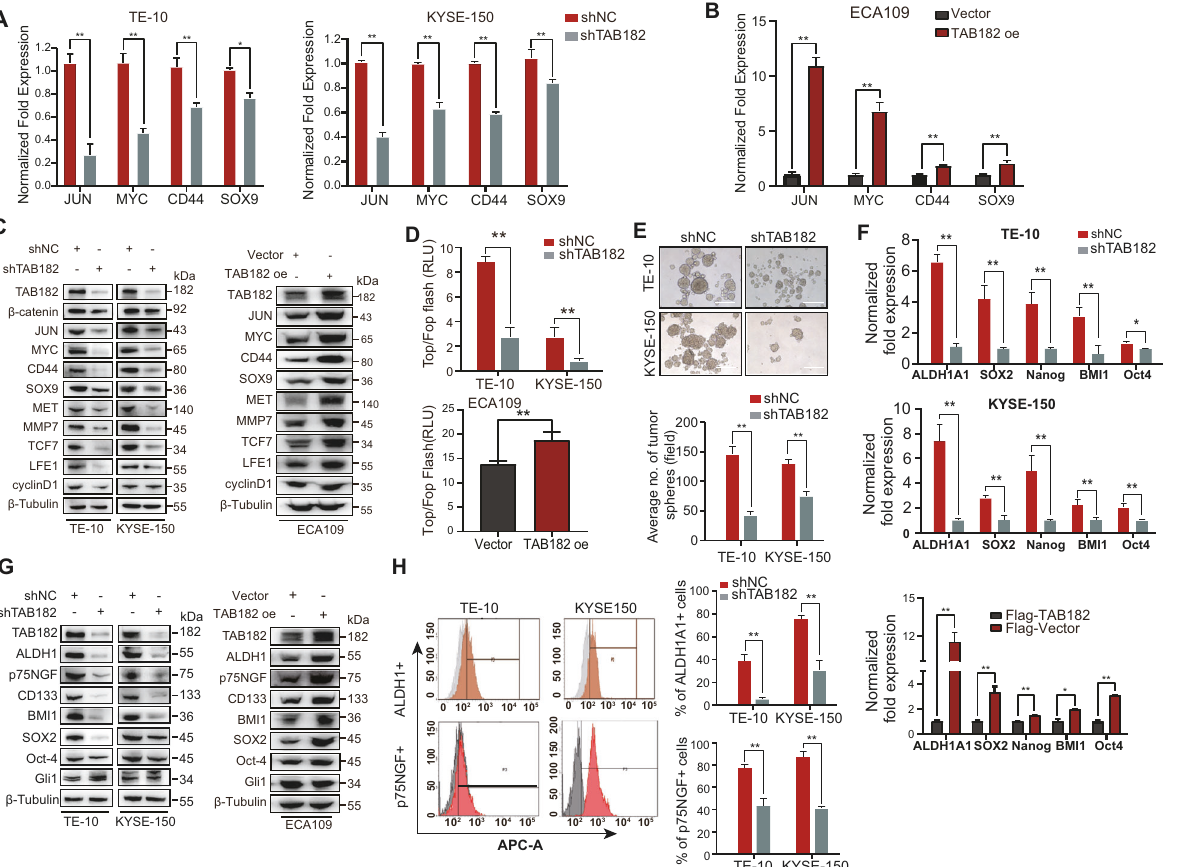
Fig. 5 Silencing TAB182 expression signi fi cantly reduces the stemness of ESCC cells. A The DNA microarray results were further con fi rmed using real-time quantitative PCR (QT-PCR). B expression levels of ALDH1A1, SOX2, Nanog, BMI1 and Oct4 were quantitatively measured using QT-PCR. C the expression of the Wnt/ β -catenin signaling pathway downstream genes, as analyzed by western blot. D TOP/FOP luciferase reporter assays were performed in KYSE-150-shNC and KYSE-shTAB182 cells. Luciferase activity was measured 48 h after co-transduced with TOP/FOP fl ash plasmid. E the formation of tumor spheres was performed to evaluate the stemness of KYSE-150 and TE-10 cells. Average number of tumor spheres formed with knockdown of TAB182 were counted at 96 h. F , expression levels of ALDH1A1, SOX2, Nanog, BMI1 and Oct4 were quantitatively measured using qRT-PCR. G the protein levels of CD133, ALDH1A1, BMI1, p75NGF and SOX2 were detected in TE10, KYSE-150 and ECA109 cells by immunoblotting. H the percentage of ALDH1A1 positive TE10 and KYSE-150 cells was analyzed using FACS. *, p < 0.05; **, p <